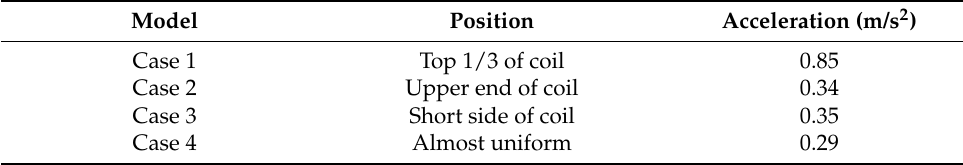
Figure 25. Acceleration comparison of different methods. Table 3. Comparison of maximum